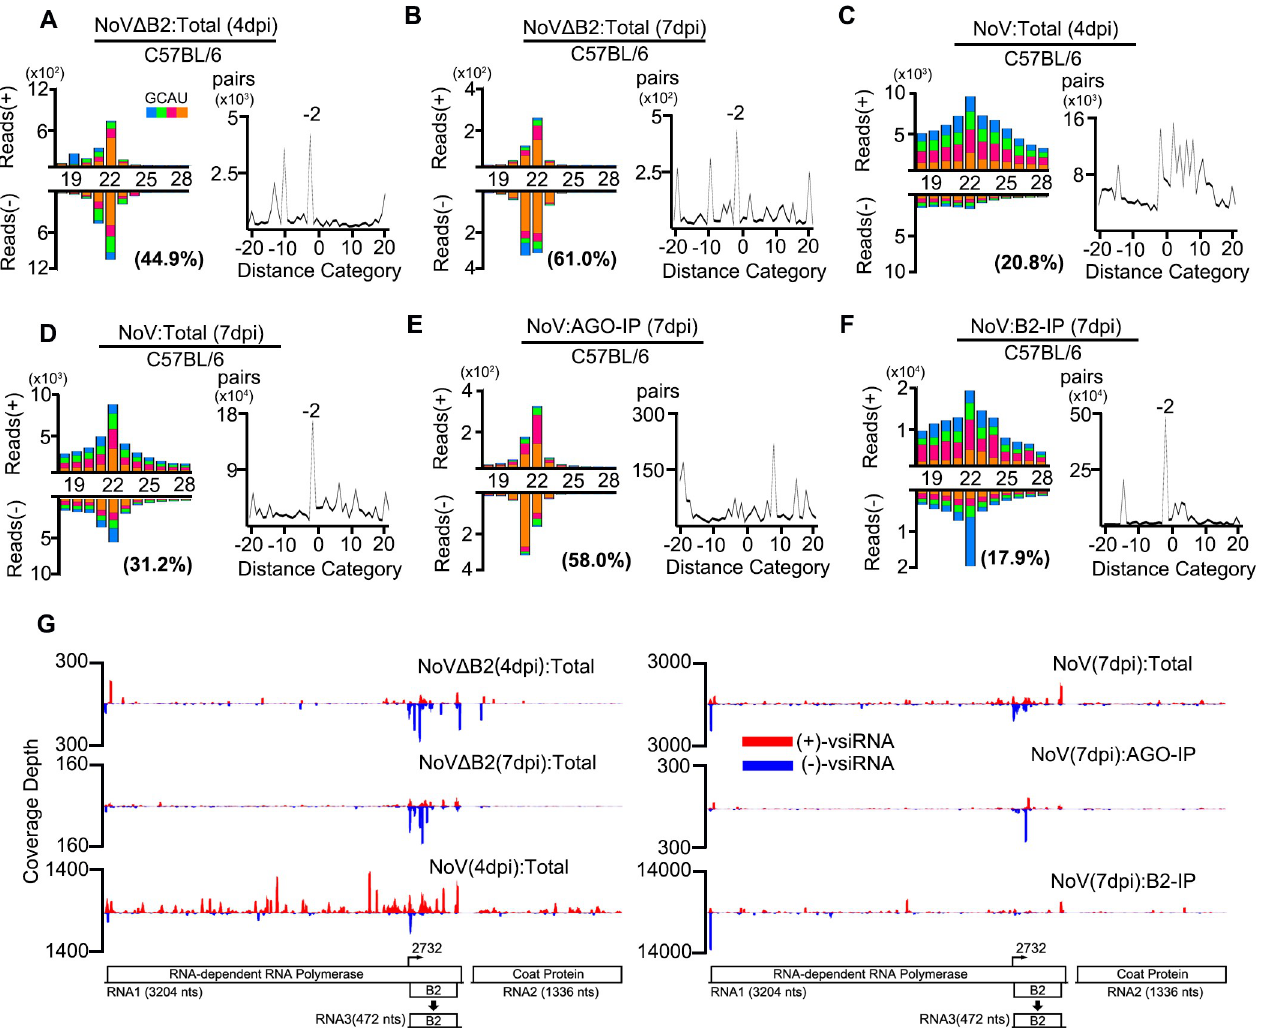
Fig 3. Abundant vsiRNAs and their sequestration by VSR-B2 in C57BL/6 mice infected with wild-type NoV. A-F. Size distribution of 18- to 28-nt virus- derived small RNAs (left) and duplex pattern of the 22-nt vsiRNAs (right) sequenced from NoV Δ B2 and NoV-infected C57BL/6 suckling mice at 4 (A, C) or 7 dpi (B, D), either with or without co-IP by antibodies specific to mouse AGOs proteins (E) or the viral B2 protein (F). G. The distribution of 21- to 23-nt vsiRNAs along the viral genomic RNAs 1 and 2 from the six libraries presented from (A) to (F). Reads are shown as per million total 18- to 28-nt reads. Data information: Same as in Fig